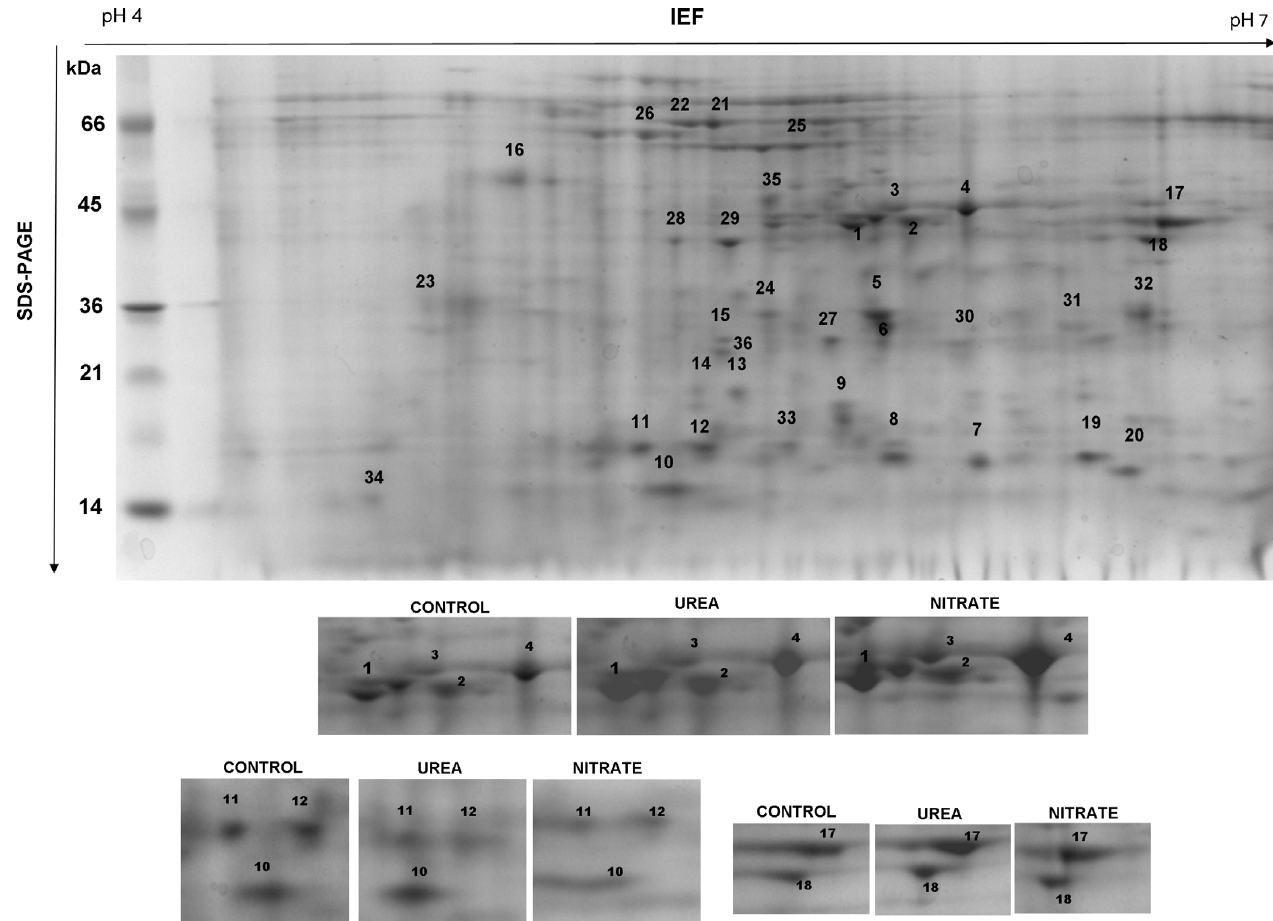
Fig 9. 2D-GE pattern of total protein extracted from durum wheat (cv Achille) immature grains. Immature grains — derived from plants fertilized with urea (UREA) and calcium nitrate (NITRATE) at the rate of 150 kg N ha -1 plus unfertilized CONTROL — were sampled at DC75 phenological stage corresponding to 15 DPA and 13 DPA in 2011 and 2012 and total protein extracts were analysed by 2D-GE. The marked spots were analysed by ESI-LC-MS/MS for protein identification. The enlargement illustrates some of the spots showing differential abundance between CONTROL and UREA and NITRATE fertilized